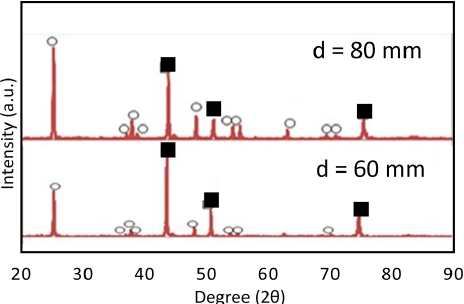
Figure 8. XRD patterns of SPS films after heat treatment ( d = deposition distance, ● : Anatase, ■ : Fe (substrate)).